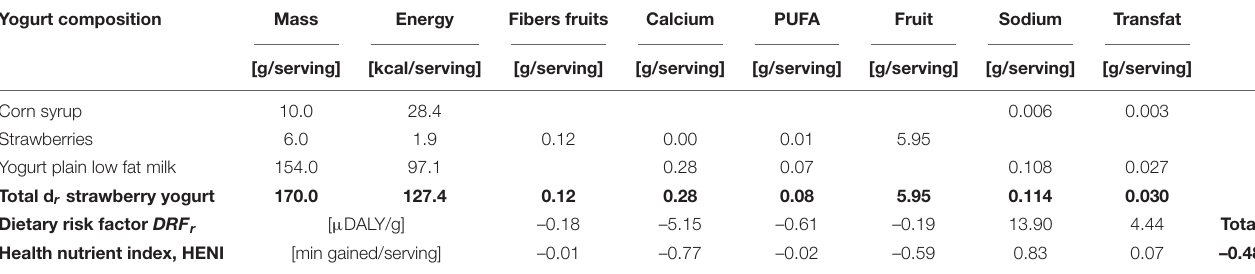
TABLE 1 | Calculation of the health nutrient index for a three ingredients strawberry yogurt [adapted from Thoma et al. (5)]. Yogurt composition Mass Energy Fibers fruits Calcium